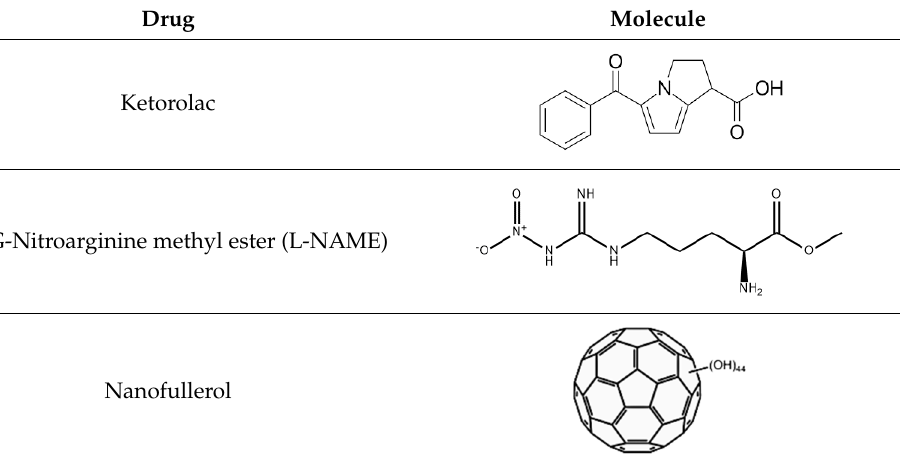
Table 1. The modulators of NO synthesis for chronic pain syndromes.